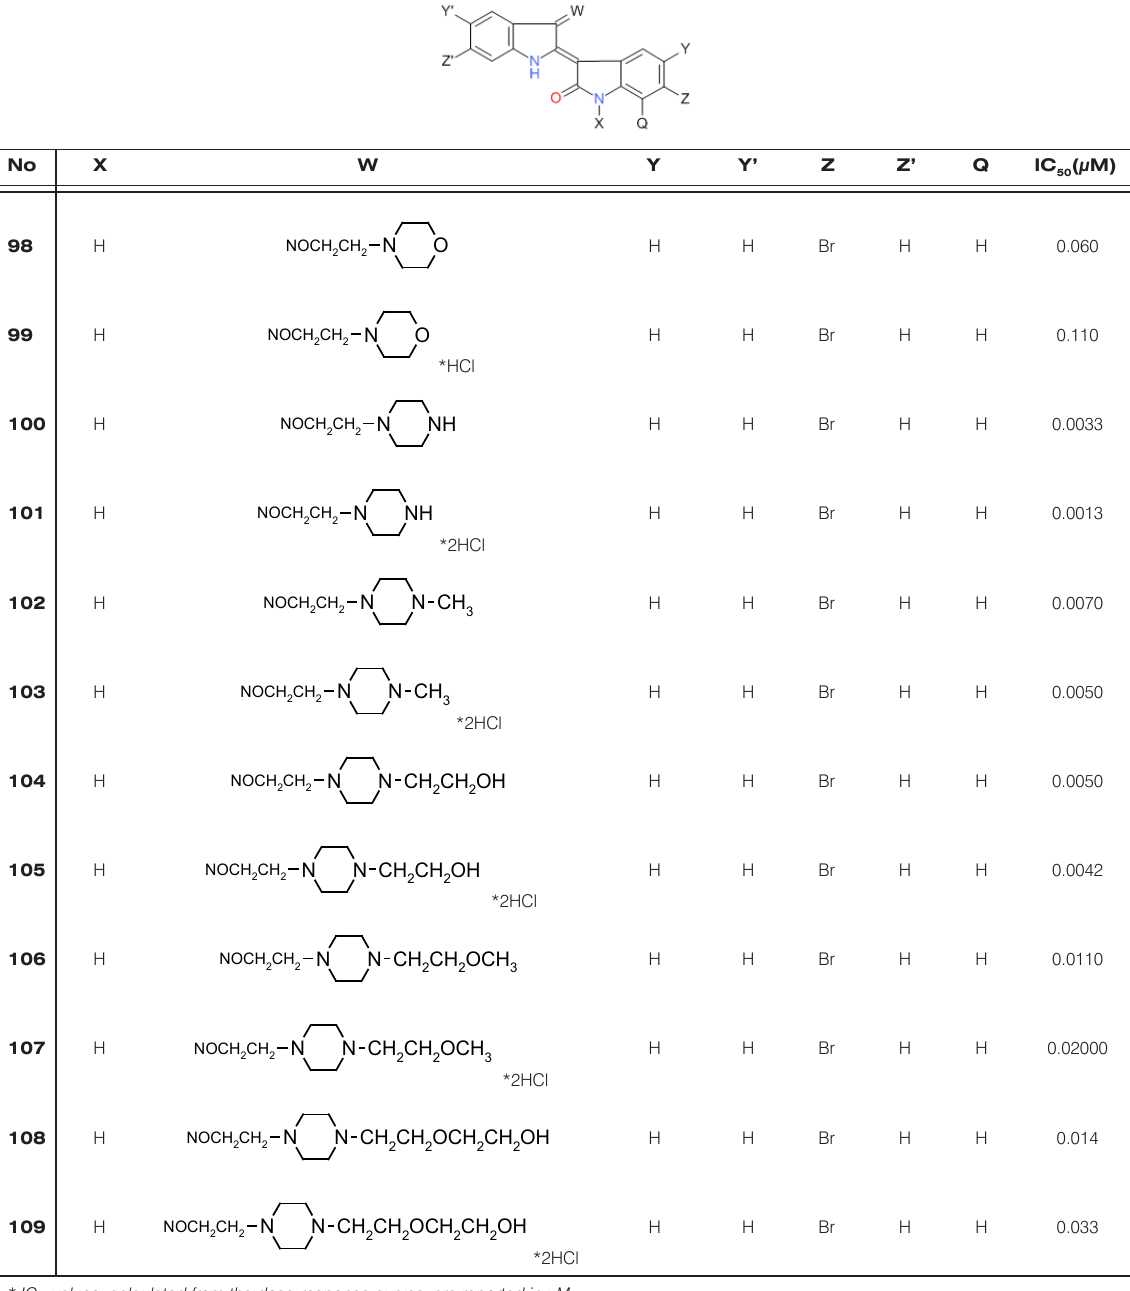
built [47]. If the PLS-DA models obtained in this manner tend to exhibit minimal R Y2 and Q Y2 values, the chance correlation bias is